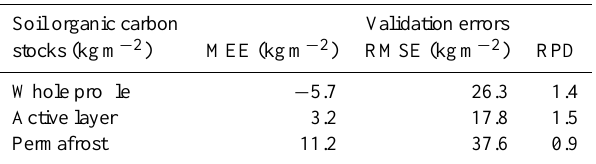
Table 1. Prediction accuracy of soil organic carbon stocks of differ- ent depth intervals. MEE is mean estimation error; RMSE is root- mean-square error; RPD is ratio of performance to